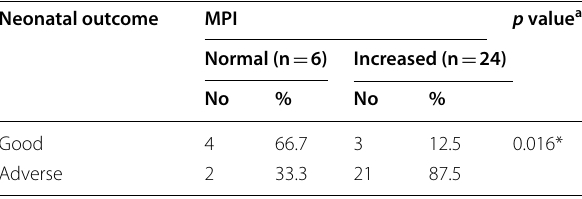
Table 6 Perinatal outcome in IUGR group with normal